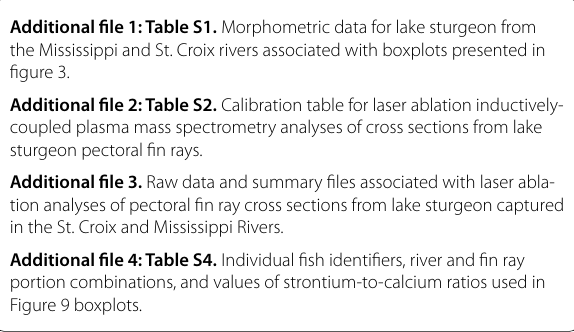
Additional file 2: Table S2. Calibration table for laser ablation inductively- coupled plasma mass spectrometry analyses of cross sections from lake sturgeon pectoral fin